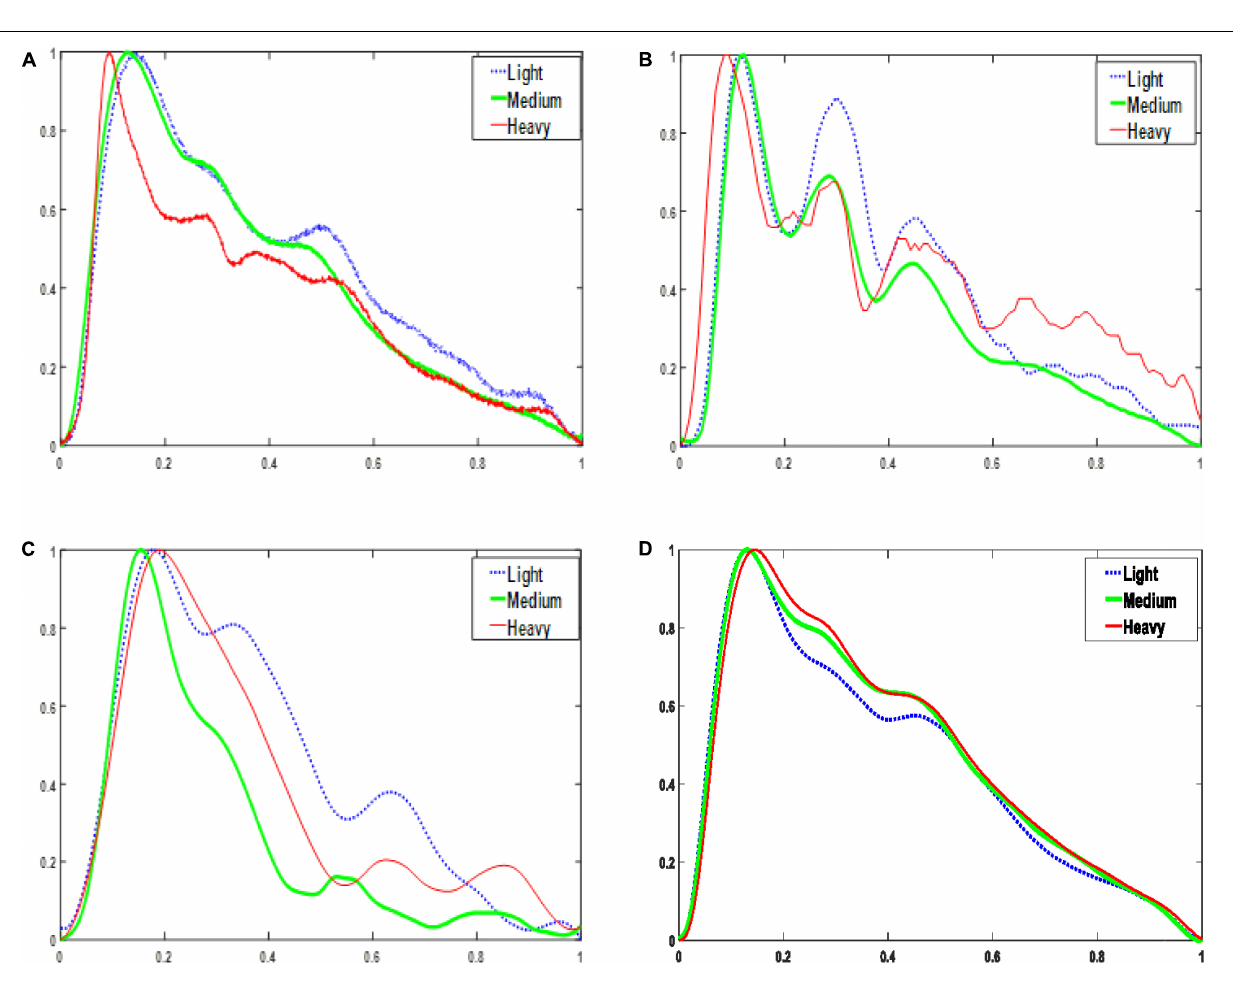
Frontiers in Physiology |